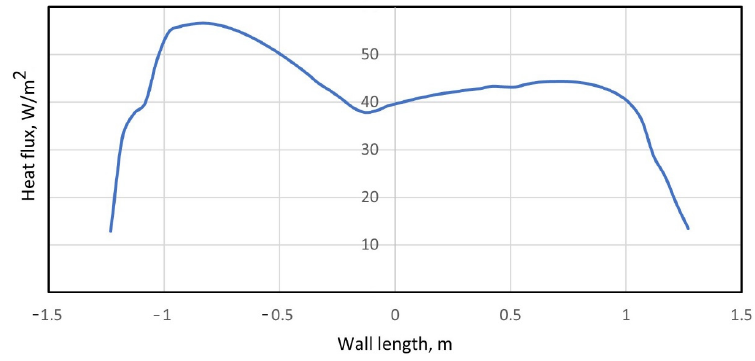
Figure 9. Heat flux q on the left wall.